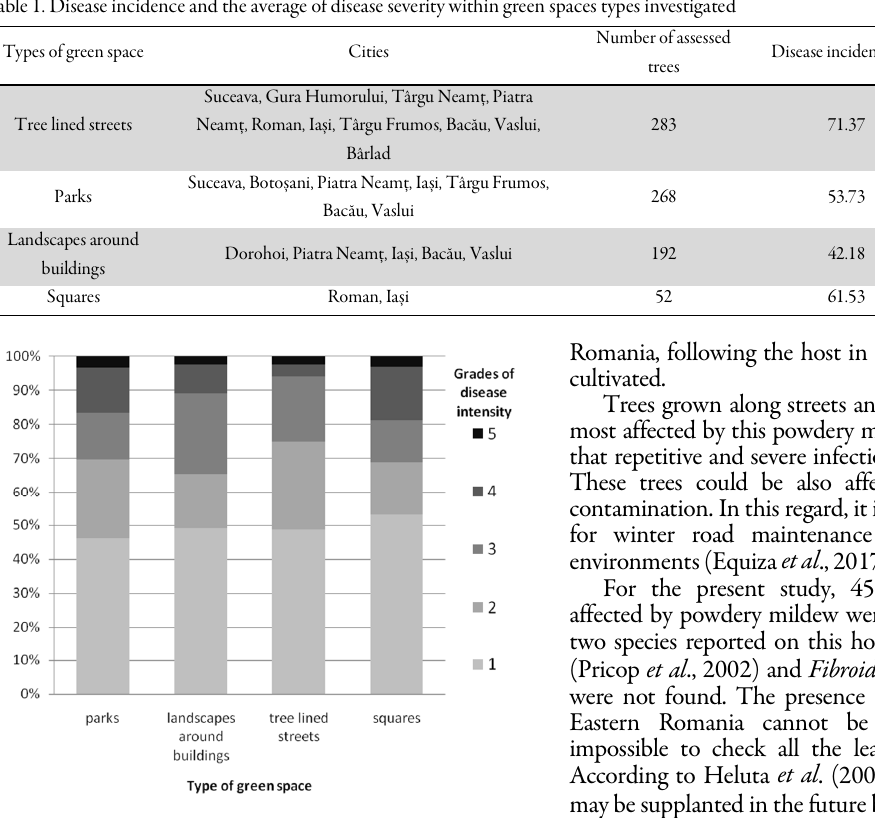
Fig. 3. Percentage distribution of the Southern catalpa trees according to disease